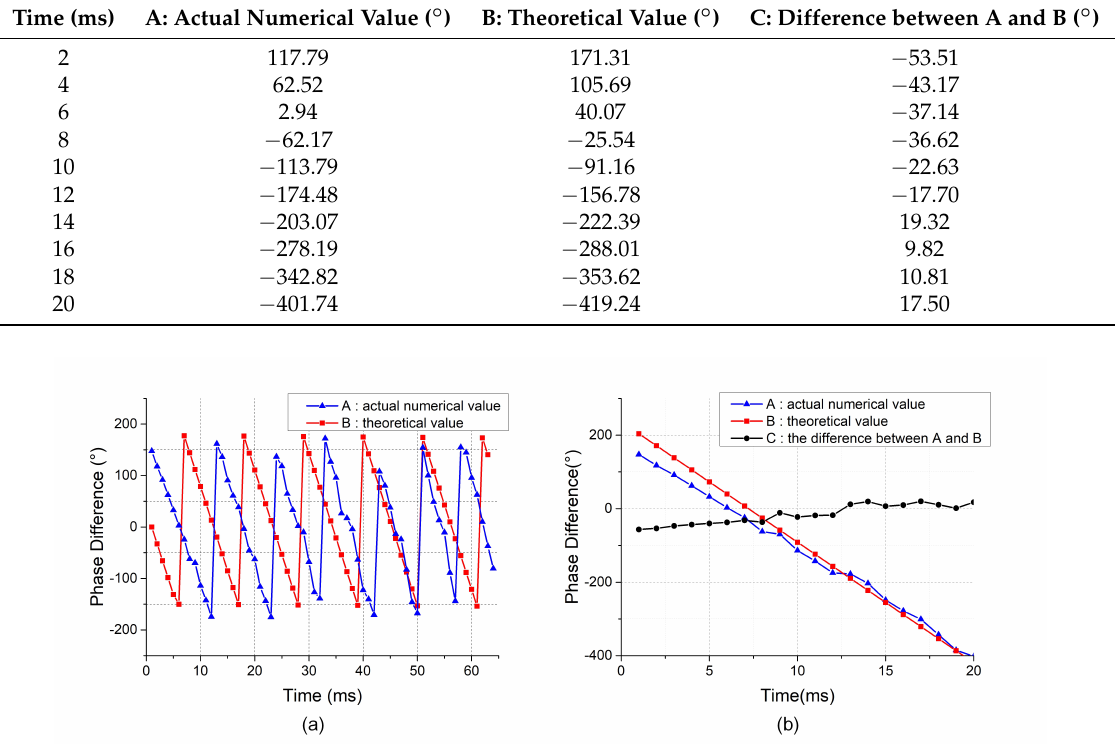
Table 2. Phase difference after unwrapping.